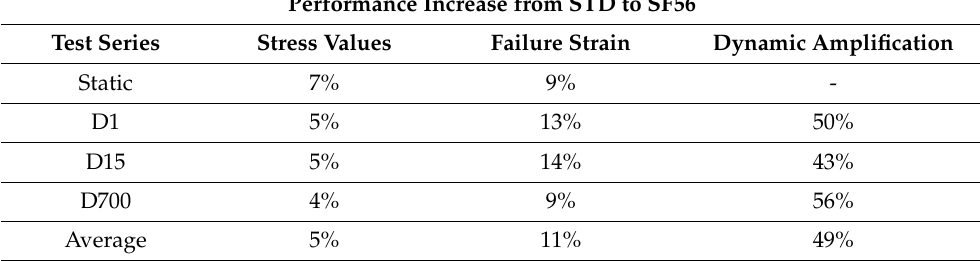
Table 4. Percentage performance increase from STD to SF56 parameter set in terms of stress values, failure strain, and dynamic